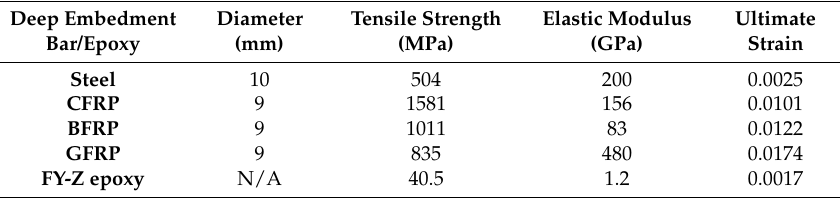
Table 2. Mechanical property of embedment bars and adhesives.